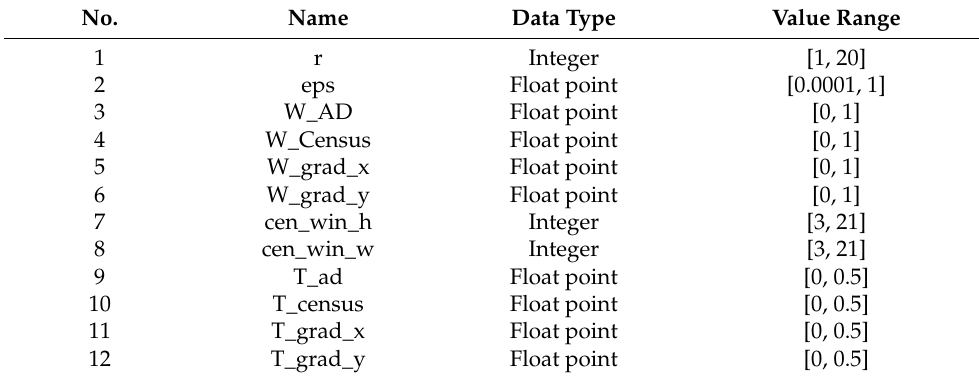
Table 2. Data type and value range of parameters in STMCF.